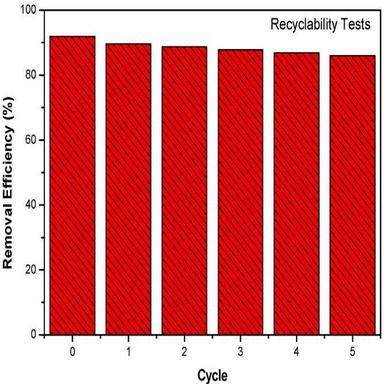
Recycling of the N-CDs/CuFe2O4 in the removal of CR dye. The initial concentration of CR was fixed at 5 mg/L and the contact time at 60 min. (A colour version of this figure can be viewed online.)